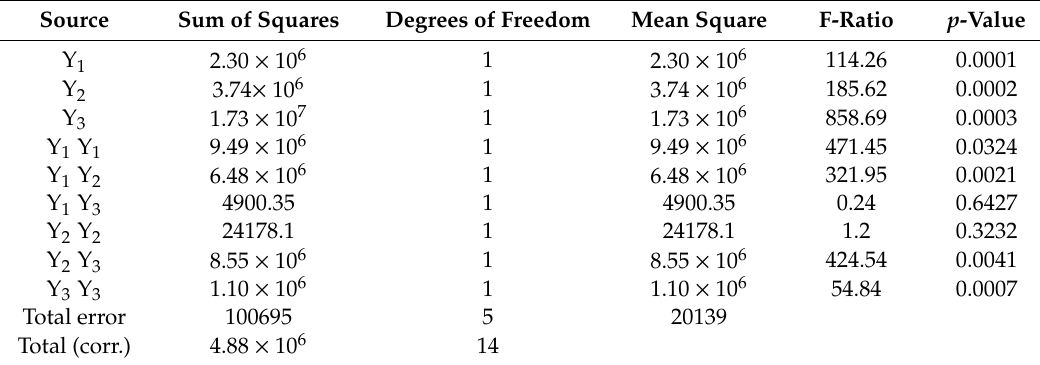
Table 8. Box–Behnken experimental design for SSF optimisation employing three independent variables, experimental, and predicted values for xylanase